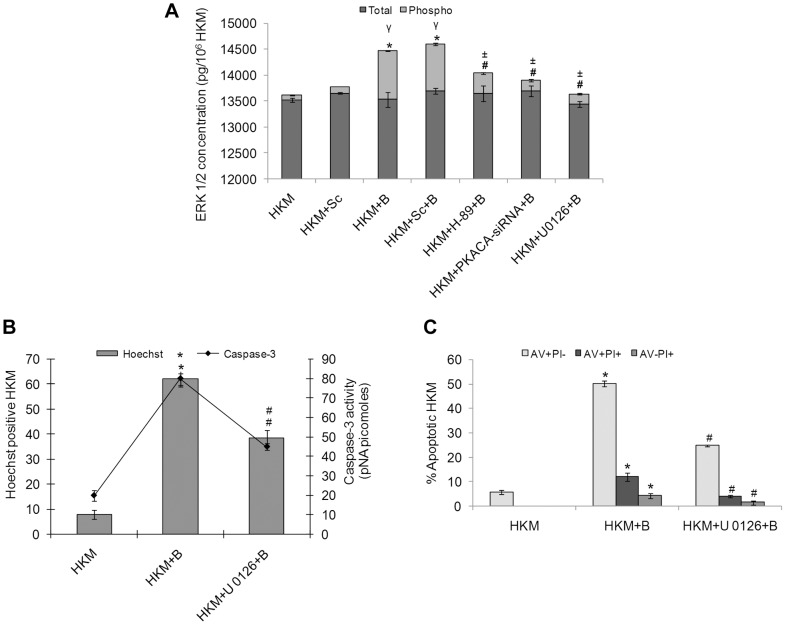

A. hydrophila-induced ERK 1/2 phosphorylation is PKA mediated and is pro-apoptotic in HKM.(A) HKM were transfected with PKACA-siRNA, scrambled siRNA or pre-treated with H-89, U 0126 then infected with A. hydrophila and checked for total ERK and pERK activity 24 h p.i. using EIA based kits. HKM were pre-treated with or without U 0126 then infected with A. hydrophila and checked for (B) Hoechst 33342 positive cells and caspase-3 activity and (C) AV-PI staining 24 h p.i. Vertical bars represent mean ± SE (n = 6). *P<0.05, compared to HKM; γP<0.05, compared to HKM+Sc; #P<0.05, compared to HKM+B; ±P<0.05, compared to HKM+Sc+B. HKM, control head kidney macrophage; HKM+Sc, HKM transfected with scrambled siRNA; HKM+B, HKM infected with A. hydrophila; HKM+Sc+B, HKM transfected with scrambled siRNA infected with A. hydrophila; HKM+PKACA-siRNA+B, HKM transfected with PKACA-siRNA infected with A. hydrophila; HKM+H-89+B, HKM pre-treated with H-89 infected with A. hydrophila; HKM+U 0126+B, HKM pre-treated with U 0126 infected with A. hydrophila.